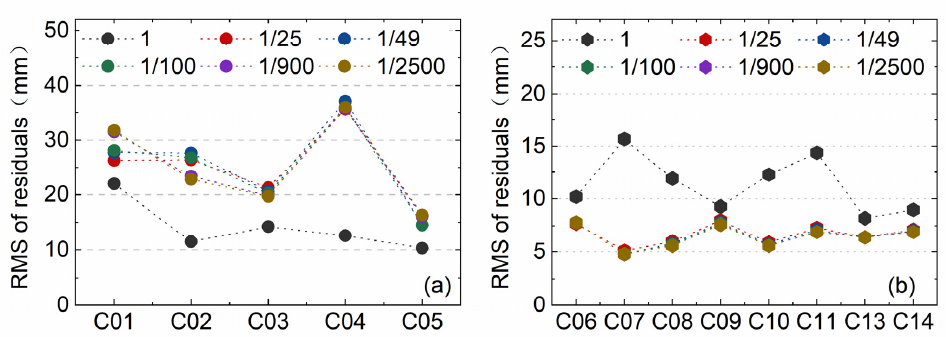
Figure 10. The RMS of di ff erent satellite residuals, ( a ) C01–C05, ( b )